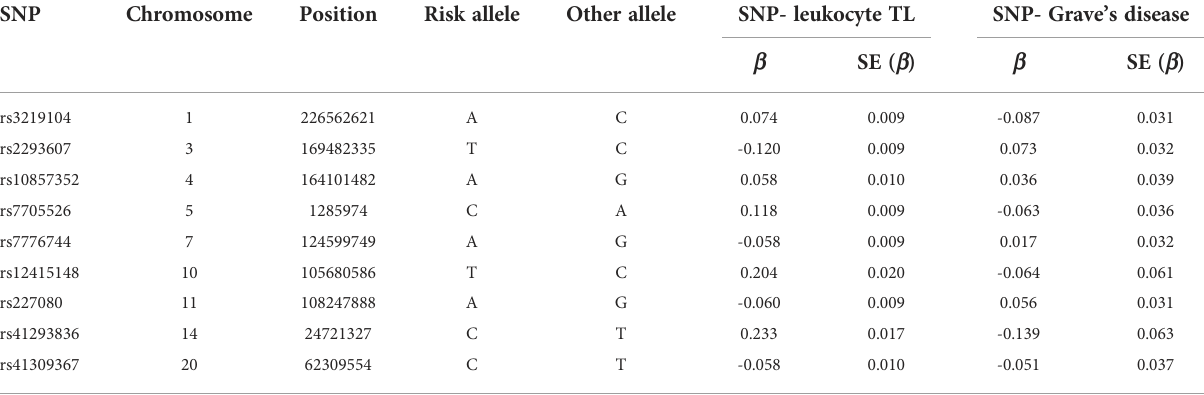
TABLE 1 SNPs used as instrument variables and its association of leukocyte TL with Grave ’ s disease.